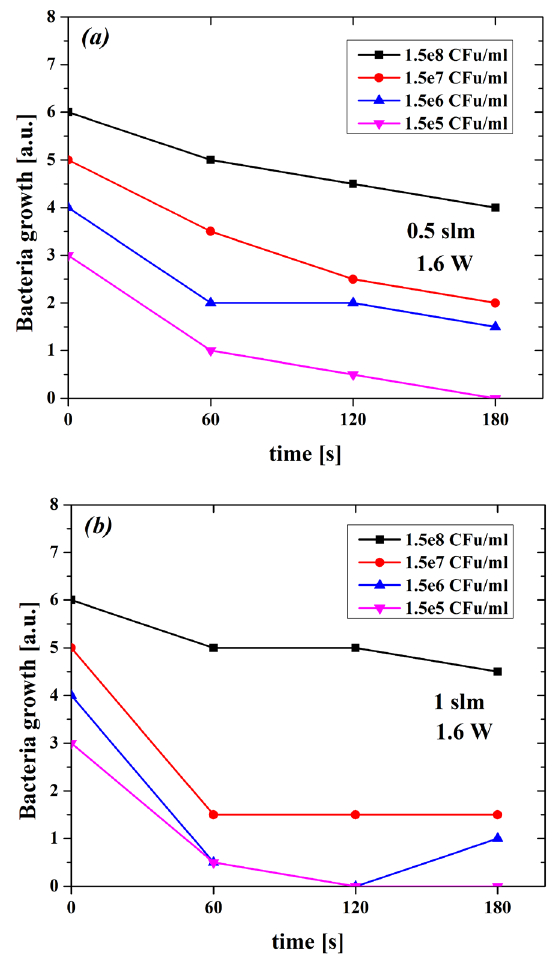
Figure 3: Sterilization of Enterococcus faecalis ATCC 29212. The samples contained four different concentrations of